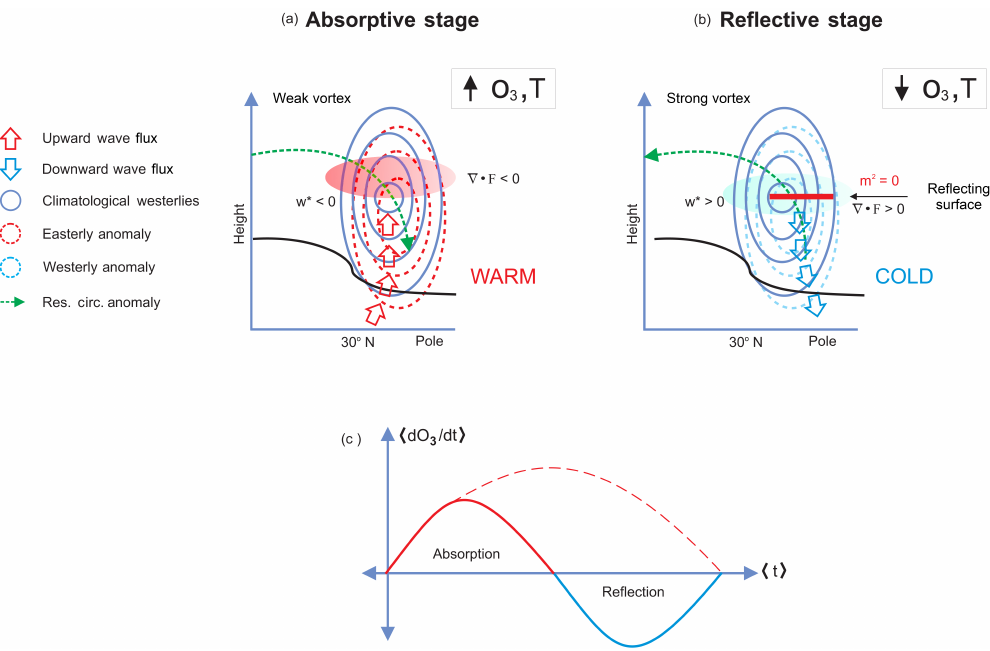
Figure 12. Schematic presentation of the DWC influence on polar stratospheric ozone over the life cycle of DWC: (a) upward absorption stage of the wave life cycle, (b) downward reflection stage of the wave life cycle, with reversed tendencies. The red (blue) shading indicates a negative (positive) anomaly in EP flux divergence. (c) The associated time evolution of ozone tendency over the life cycle of DWC, where the absorptive and reflective stages are denoted by the red and blue solid lines, respectively. In contrast, the evolution of ozone tendency associated with the life cycle of upward wave events, which consist only of a longer absorption stage, is denoted by the red dashed